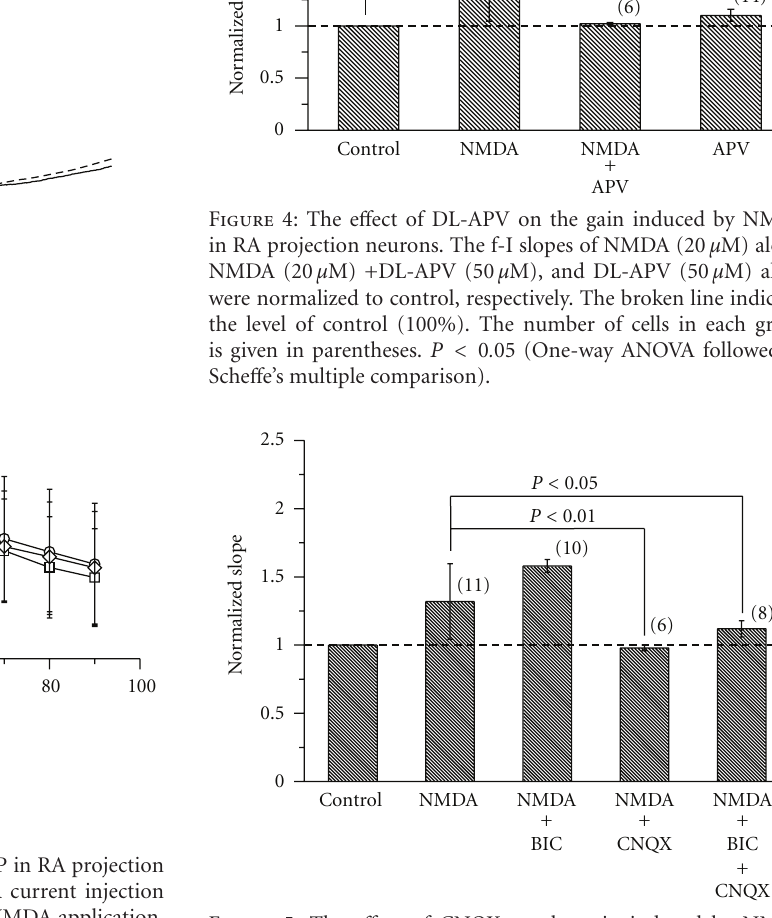
Figure 5: The e ff ect of CNQX on the gain induced by NMDA in RA projection neurons. The results were obtained with NMDA (20 μ M), NMDA (20 μ M) in the presence of bicuculline methiodide (BIC, 10 μ M), NMDA (20 μ M) in the presence of CNQX (10 μ M), NMDA (20 μ M) in the presence of BIC (10 μ M), and CNQX (10 μ M). The slopes were normalized to those of controls. The broken line indicates the level of control (100%). The number of cells in each group is given in parentheses. P < 0 . 05 or P < 0 . 01 (one-way ANOVA followed by Sche ff e’s multiple